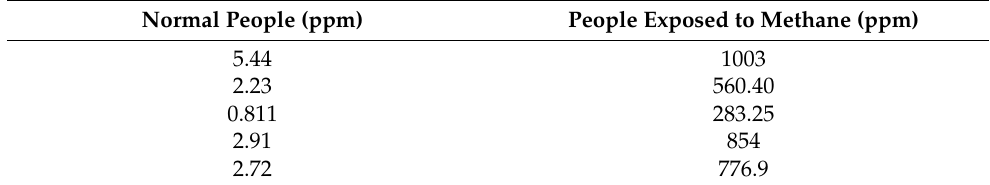
Table 5. Methane gas percentage readings between people exposed to it on a daily basis and normal people.